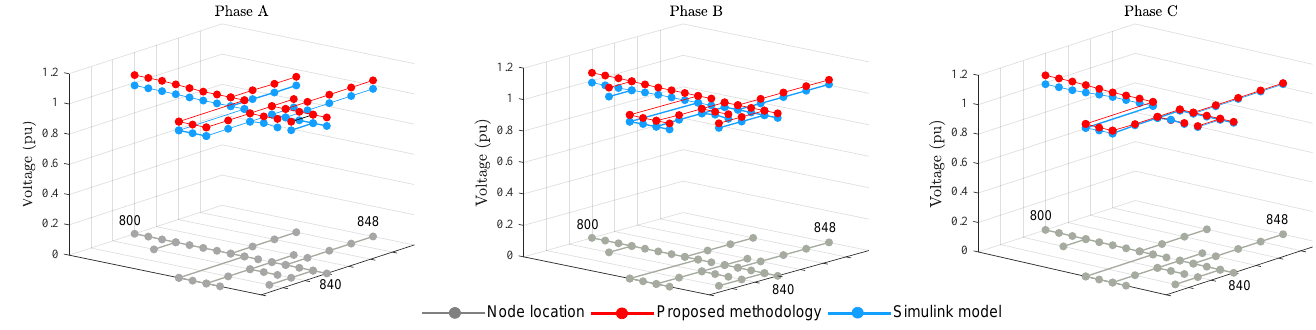
Figure 7. Voltage profiles obtained by the proposed method and the Simulink model, with 100% of κ A .